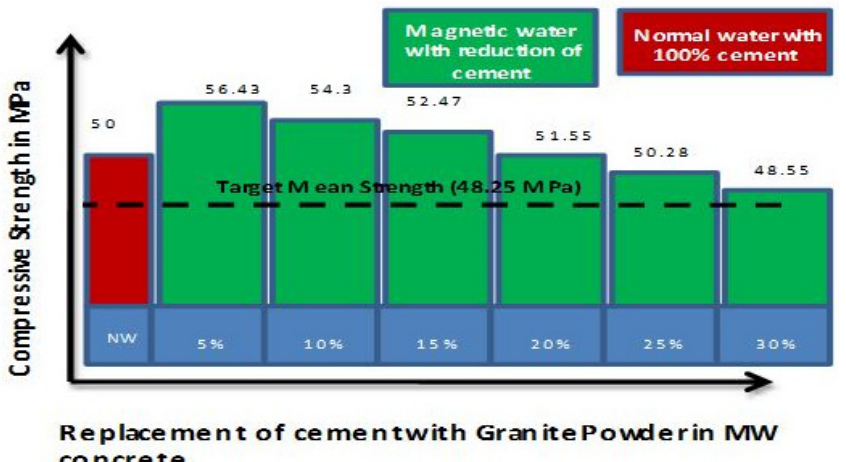
Figure 10. Compressive strength of concrete with cement reduction (NW with 1% optimized SP vs. MW with 0% SP).